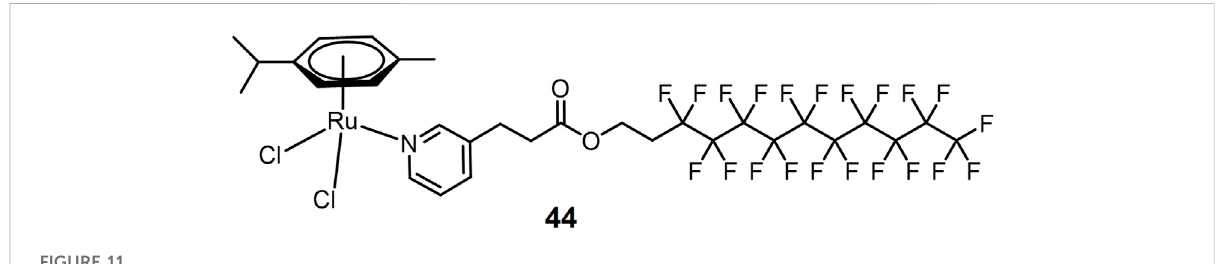
FIGURE 11 Thermoresponsive Ru(II)